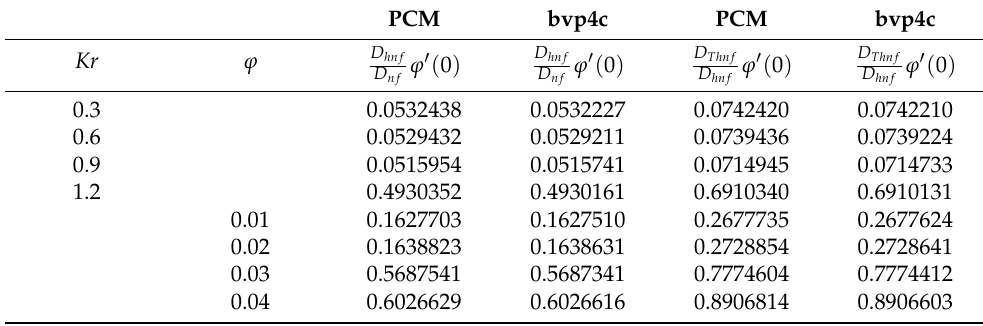
Table 3. Comparative assessment for Sherwood number between PCM and bvp4c package with hybrid and ternary hybrid